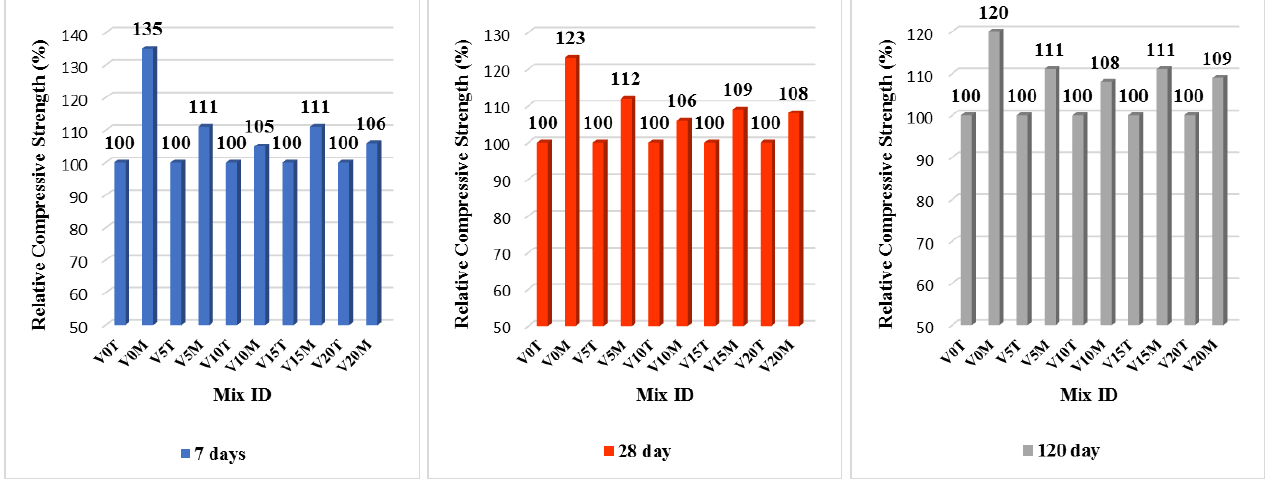
Figure 11. Effect of MW on compressive strength of volcanic concrete at 7, 28, and 120 days.